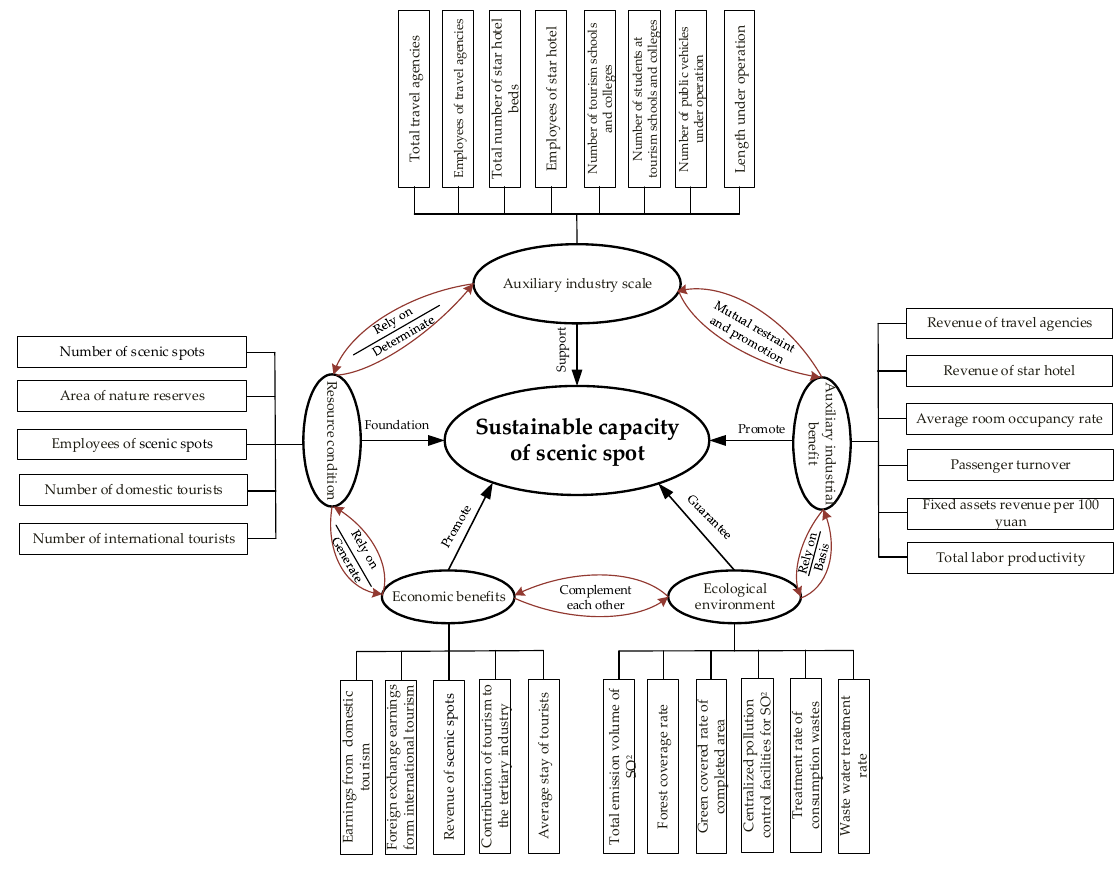
Figure 2. Indicator Logic Diagram.